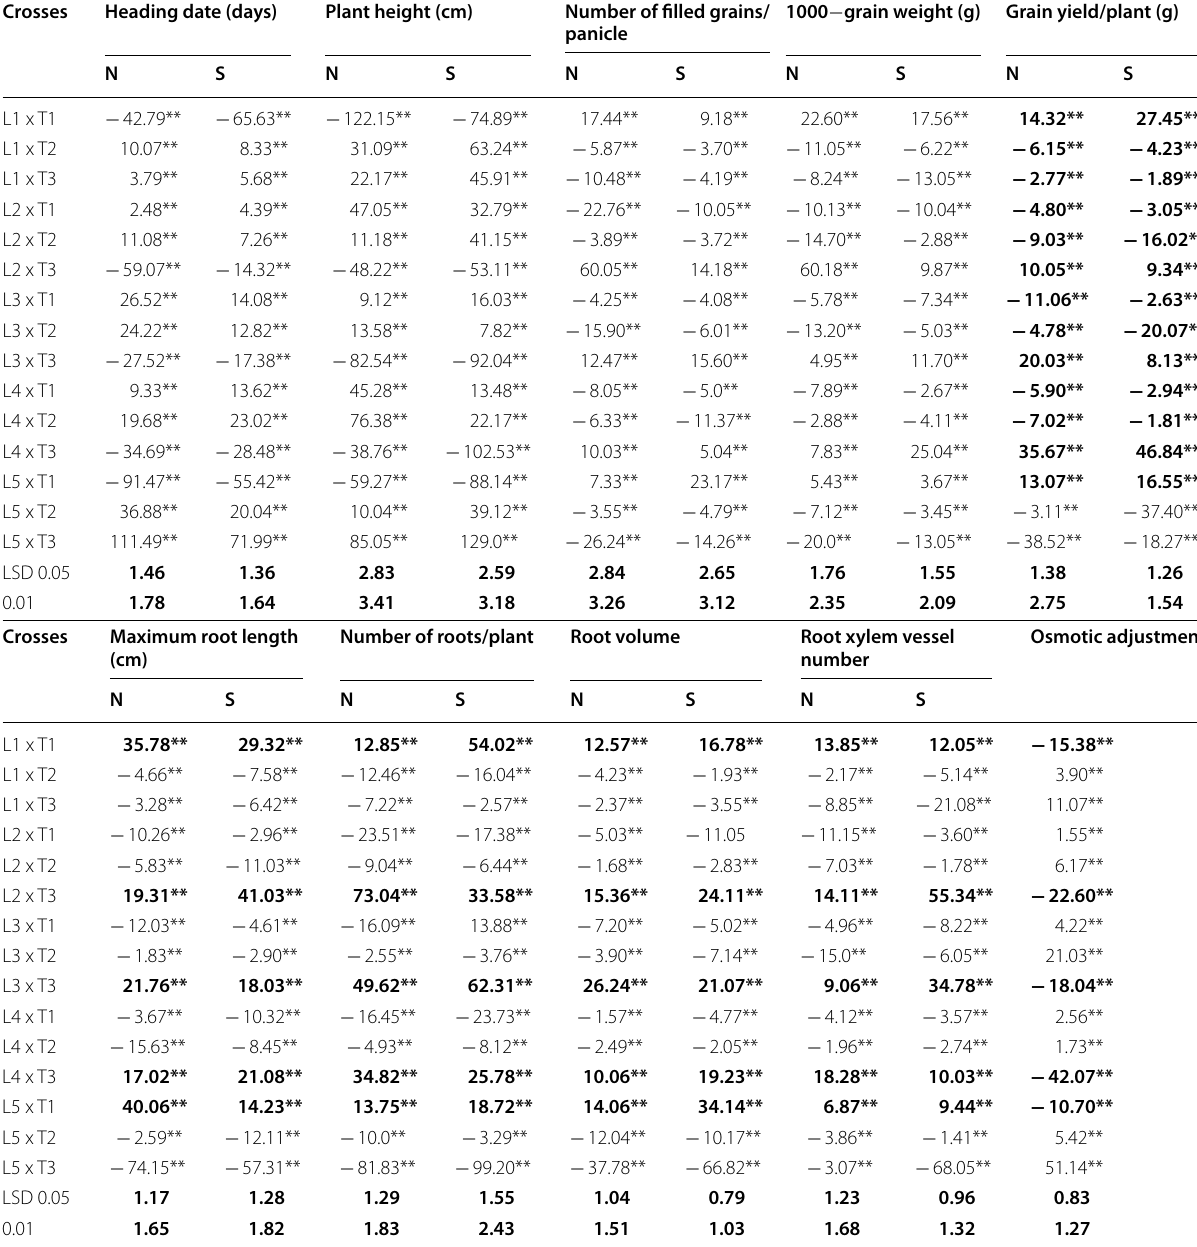
Table 6 Estimates of specific combining ability effects in the 15 rice hybrids for all characters evaluated under both normal and drought stress conditions Crosses Heading date